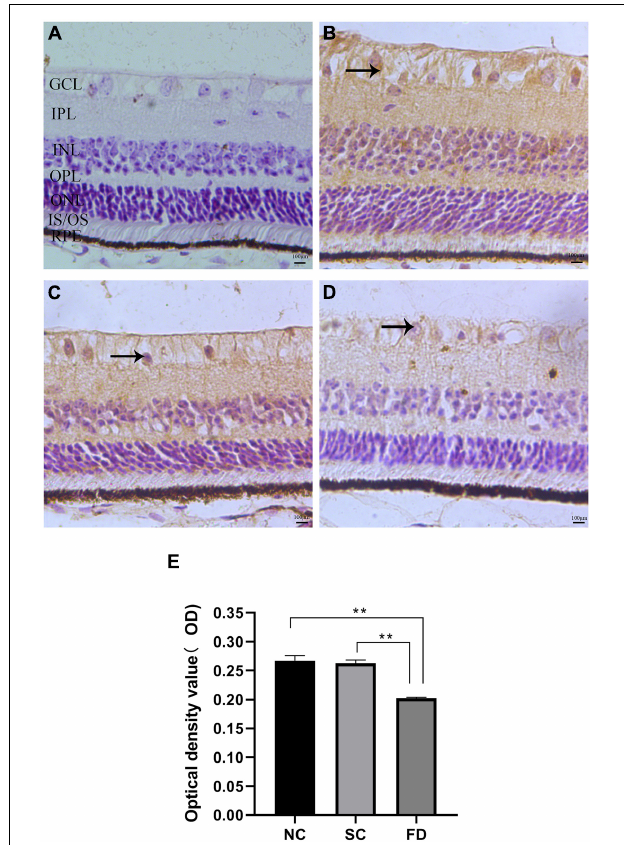
FIGURE 4 | Expression and distribution of KCNQ5 in each layer of the retina. (A–D) Showed the immunohistochemical staining results of each group; (E) showed the statistical results of the average optical density of the immunohistochemical images. (A) Negative control, the staining after incubation with PBS; (B) the NC group; (C) the SC group; (D) the FD group; GCL, ganglion cell layer; IPL, inner plexiform layer; INL, inner nuclear layer; OPL, outer plexiform layer; ONL, outer nuclear layer; IS/OS, inner and outer segments of photoreceptor; RPE, pigment epithelial layer. The positive expression of KCNQ5 in the retina was brown. The scale was 100 µ m and the magnification was 400 times (** P < 0.01).